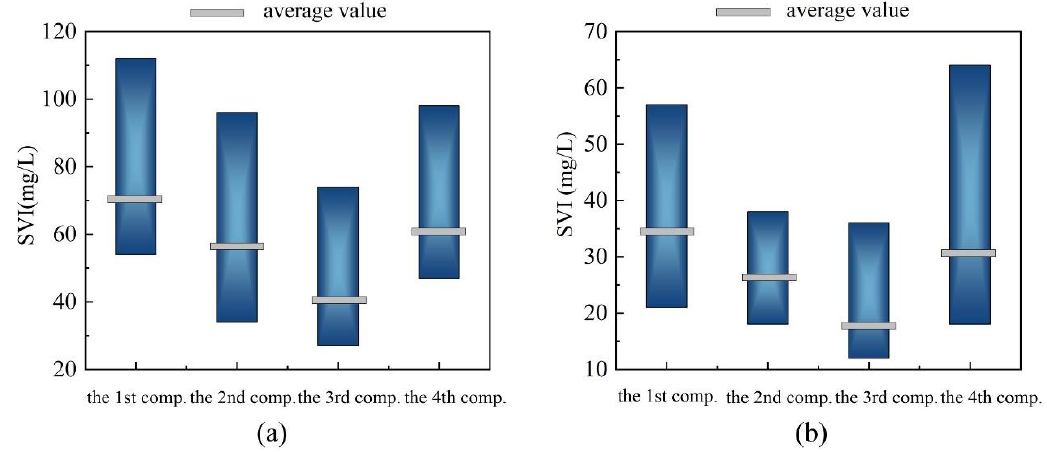
Figure 4. SVI of four compartment on ( a ) the 35th day and ( b ) the 45th day during start-up.